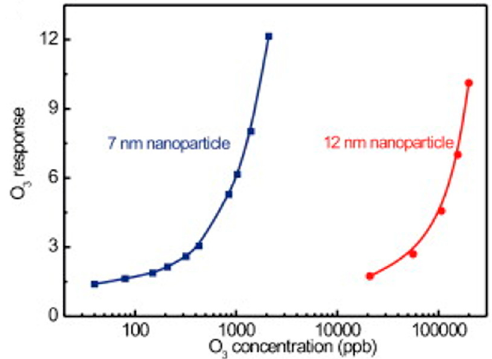
Figure 21. O 3 response vs. size of In 2 O 3 nanoparticles. ( blue line) 7 nm and ( red line) 12 nm. Reproduced with permission from [58].